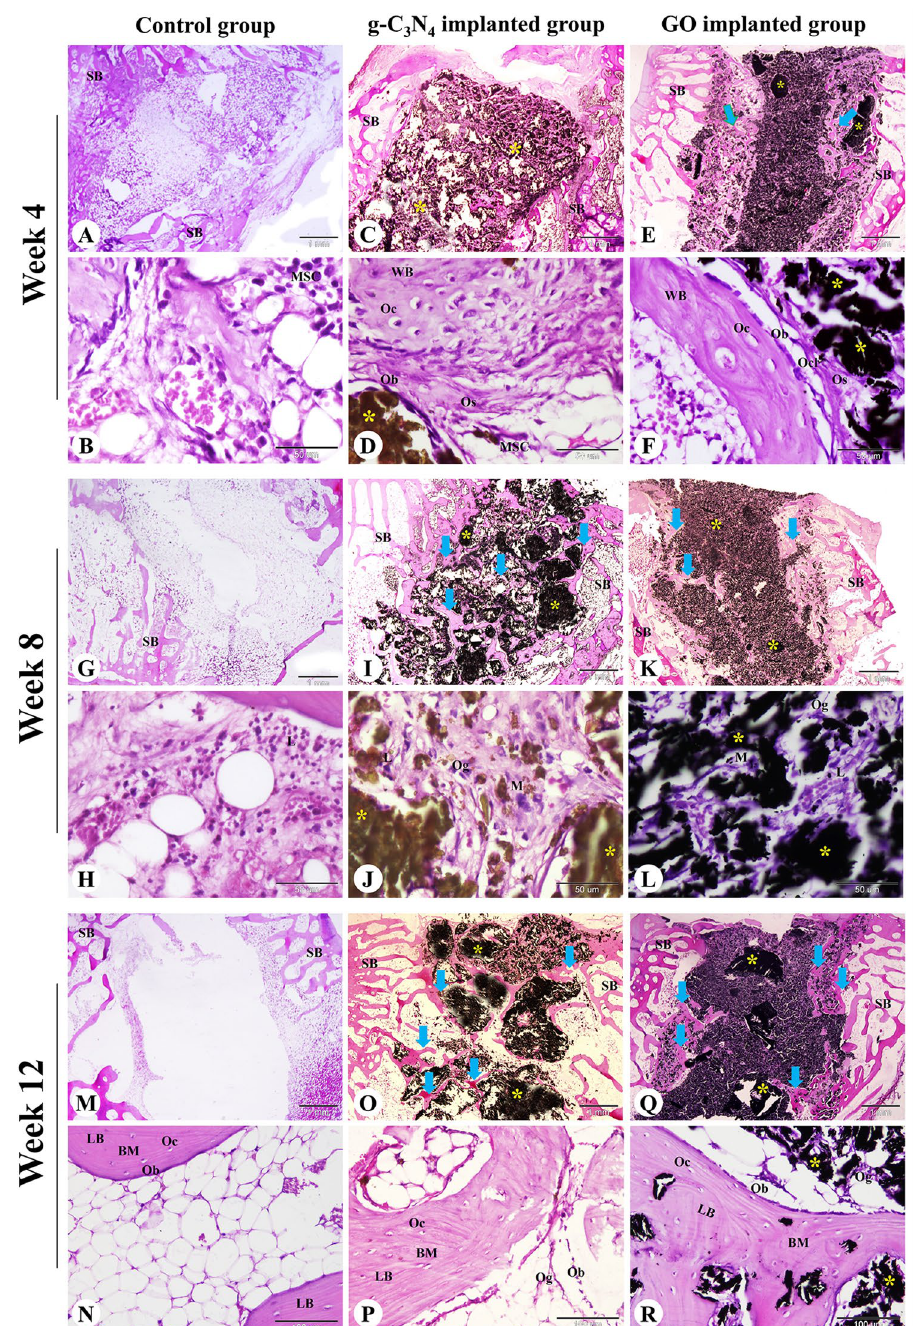
Figure 4. Histological evaluation of femoral condyle defects in rabbits. The repair site of the femoral condyle at week 4 ( A – F ), 8 ( G – L ), and 12 ( M – R ) after surgery in control, g-C 3 N 4 implanted, and GO implanted groups was stained with H&E. SB spongy bone, MSC mesenchymal stem cell, Ob osteoblast, Oc osteocyte, Ocl osteoclast, Og osteogenic cells, Os osteoid tissue, BM bone matrix, WB woven bone, LB lamellar bone, L lymphocyte, M macrophage; yellow asterisks: implanted nanomaterial; blue arrows: newly formed spongy bone. The scale bars in panels ( A , C , E , G , I , K , M , O , and Q ) = 1 mm, panels ( N , P , and R ) = 100 μm, panels ( B , D , F , H , J , and L ) = 50